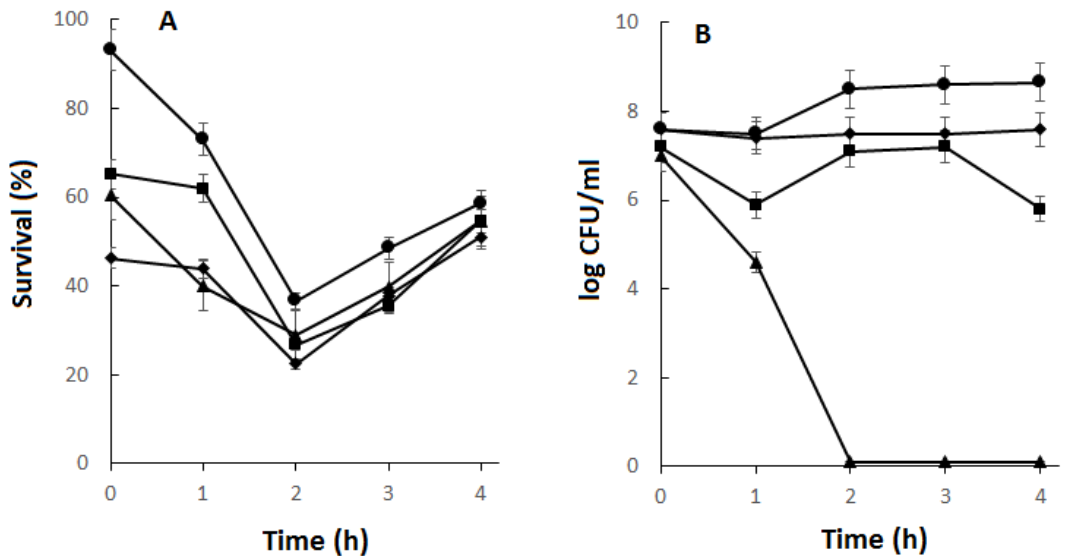
Figure 1 – Tolerance of E. durans LAB18S to bile salts and acid pH. (A) The strain was incubated for up to 4 h at 37 °C in the presence of bile salts at concentrations 2.5 mg/mL (●), 5.0 mg/mL (■), 10 mg/mL (▲) or 15 mg/mL (♦). Results are expressed as percentage of surviving cells in comparison to incubation without bile salts used as a control. (B) The strain was incubated for up to 4 h at 37 °C in pH 2 (▲), 3 (■), 4 (♦) or 7 (●). Viable cell counts were monitored at each 1 h interval. Values are the means ± standard deviations of three independent experiments.